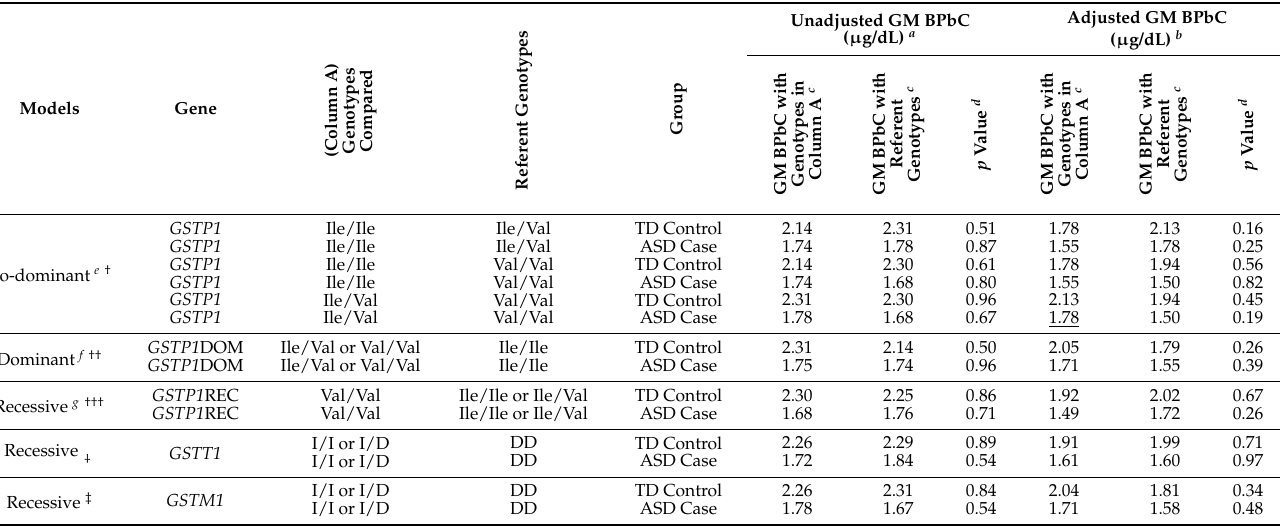
Table 4. Unadjusted and adjusted geometric mean blood Pb concentration (GM BPbC) by GST genotypes based on general linear models (GLMs) that include interaction between GST genes and ASD case status (ASD and TD control)